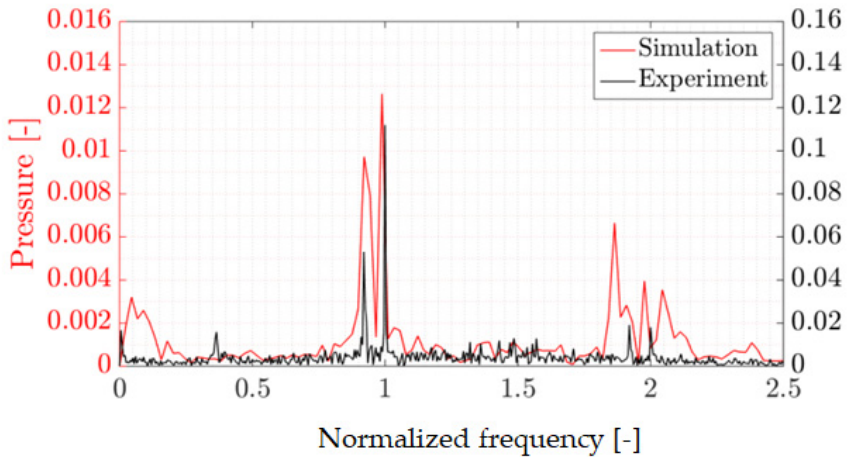
Figure 11. Amplitude spectrum of the pressure at P-PS-4 (pressure side, near the leading edge). Two vertical axes are used; numerical results—red, experimental results—black.